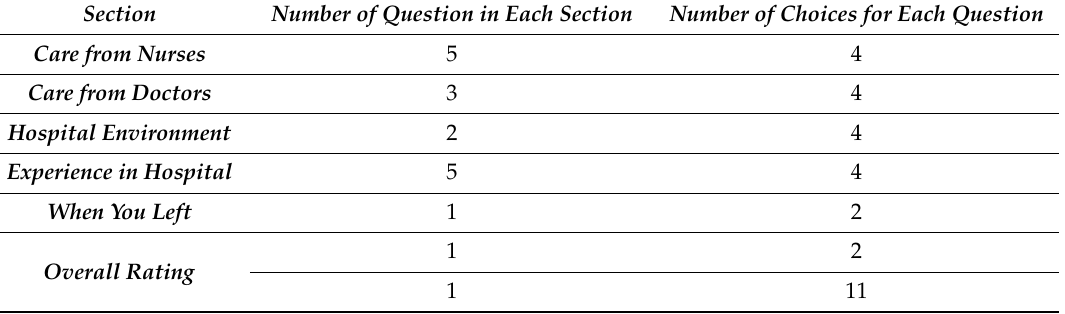
Table 1. Satisfaction Questions Categories.